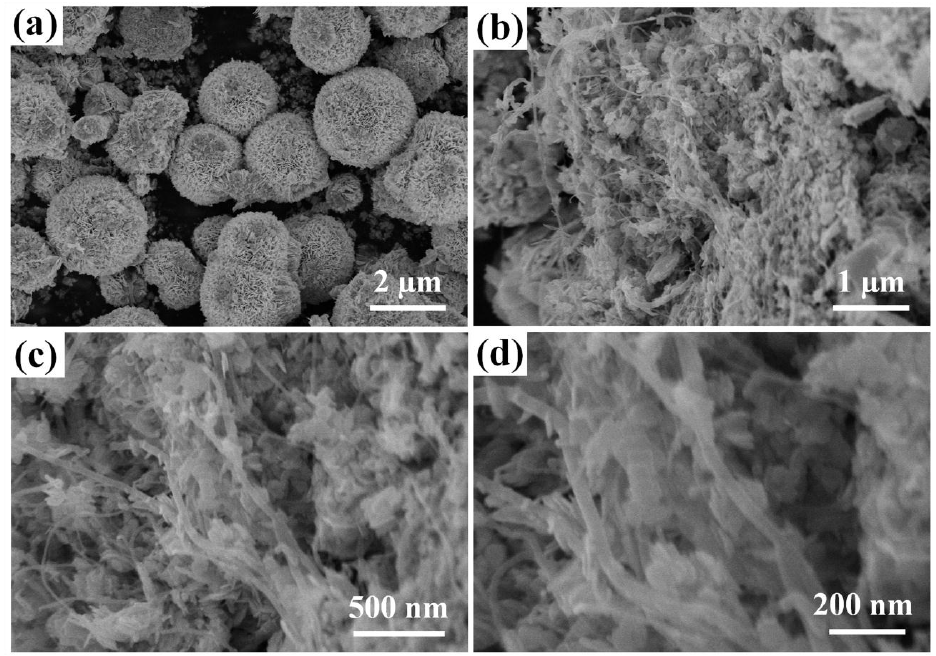
Figure 2. Scanning electron microscopy (SEM) images of ( a ) BiOI , and ( b – d ) 3%M-Bi.